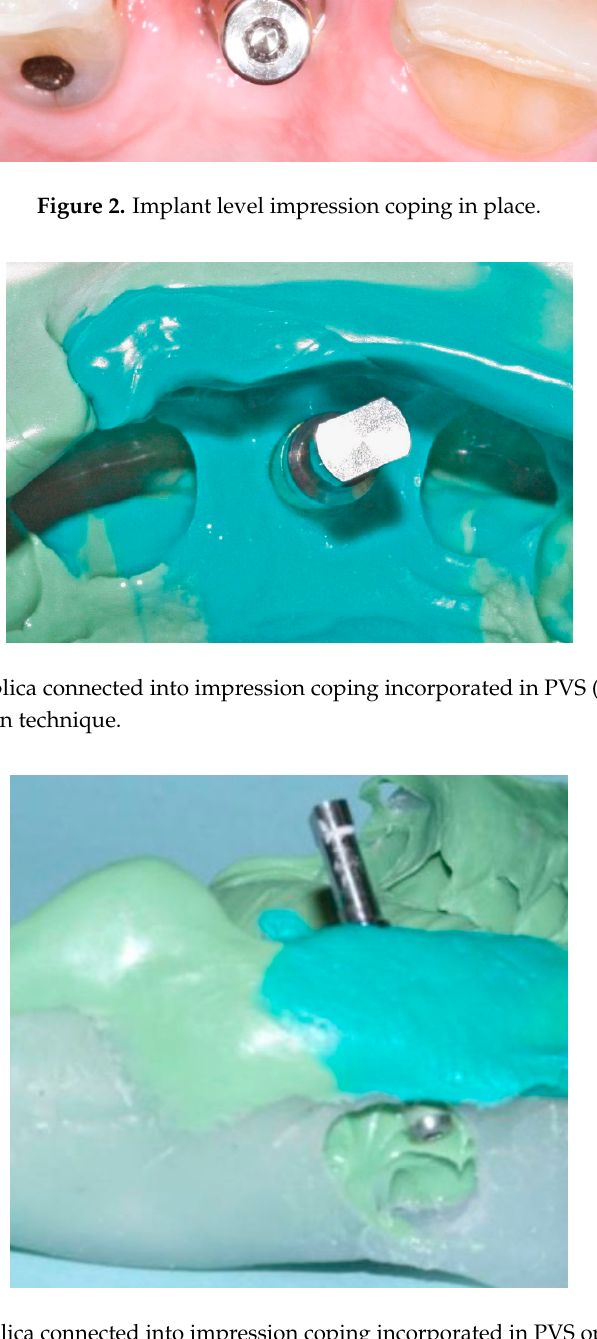
Figure 4. Implant replica connected into impression coping incorporated in PVS open tray impression technique due to malposition implant placement.